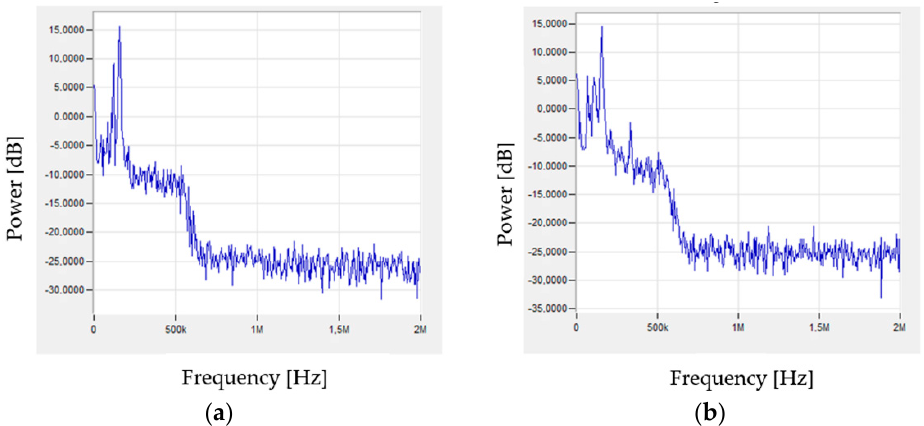
Figure 8. Examples of signals, after FFT analysis, characteristic for matrix deformation: ( a ) sample of pure resin, ( b ) composite.